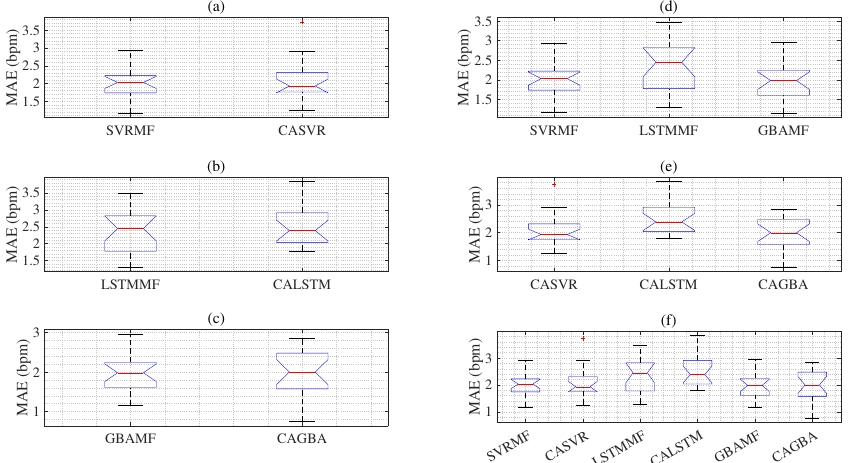
Figure 5. The box below represents the MAE and SD compared to the reference RR method obtained using the BIDMC dataset; where ( a ) is the MAE results of SVRMF and CASVR, ( b ) denote the MAE results of LSTMMF and CALSTM, ( c ) is the MAE results of GBAMF and CAGBA, and ( d ) denote the MAE results of SVRMF, LSTMMF, and GBAMF, ( e ) is the the MAE results of CASVR, CALSTM, and CAGBA, and ( f ) is the MAE results of all